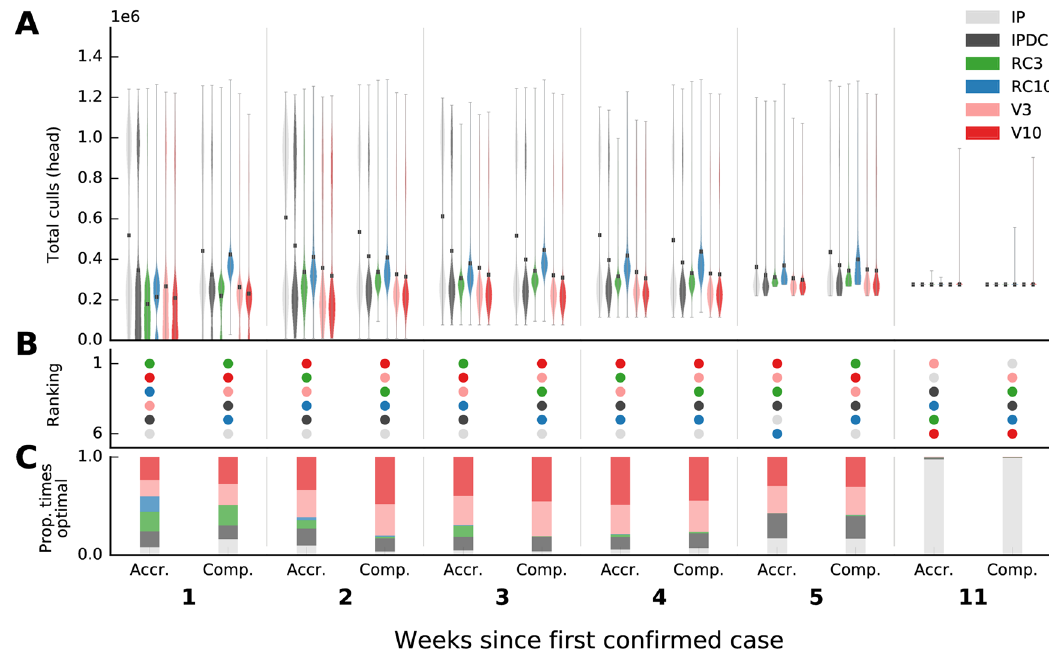
Fig 3. Projections and relative rankings of various control strategies of total animals culled, and estimates of infected but undetected farms, for the first five weeks and final week of the 2010 foot-and-mouth disease outbreak in Miyazaki, Japan. A) Distribution of total animal culls from forward simulations, here shown as kernel density estimates (violin plots), are seeded either using parameter estimates from the end of the outbreak (Comp.; ‘complete’), or at the specific time point (Accr.; ‘accrued’). B) Rankings of control interventions are according to mean projections. Proportion (C) of times each control was optimal when bootstrap samples are made from distributions in (A). For all time points see S11 Fig.